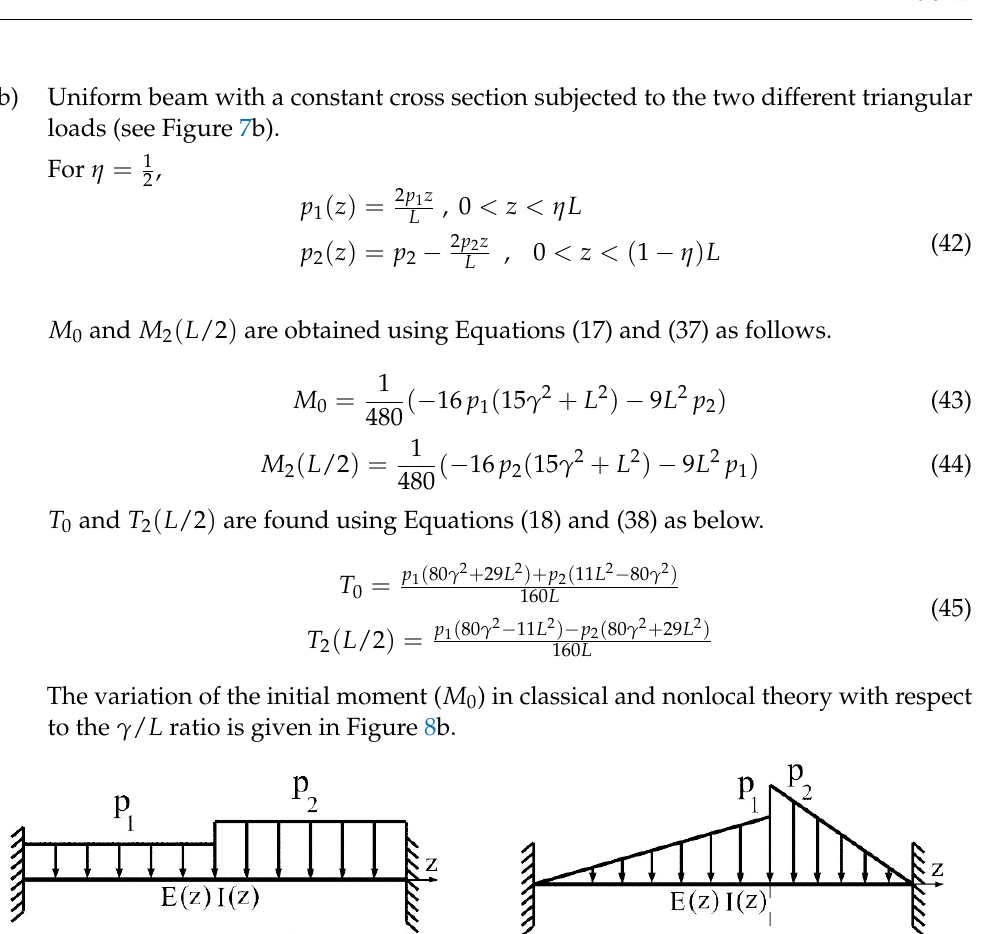
Figure 7. ( a ) Uniform beam with a constant cross section subjected to the two different uniform loads; ( b ) uniform beam with a constant cross section subjected to the two different triangular loads.